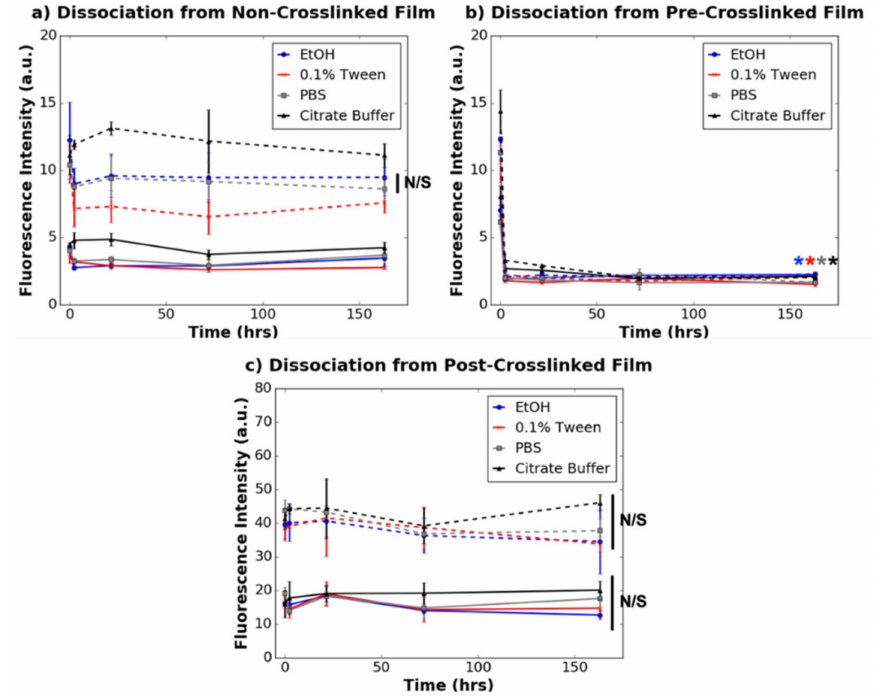
Figure 4. Dissociation of 8% dye-tagged dendrimers from ( a ) non-crosslinked films, ( b ) pre- crosslinked films, and ( c ) post-crosslinked films. Solid and dotted lines correspond to 0.74 µ g/mg and 1.49 µ g/mg dendrimer loading concentrations, respectively. N/S denotes p ≥ 0.05. * denotes statistically significant difference ( p ≤ 0.01) between the data point annotated (colour-coded) and the respective 0 h value for each collagen substrate. Statistical significance is only depicted for 1.49 µ g/mg dendrimer quantities for non-crosslinked and pre-crosslinked films and only for the final time point for